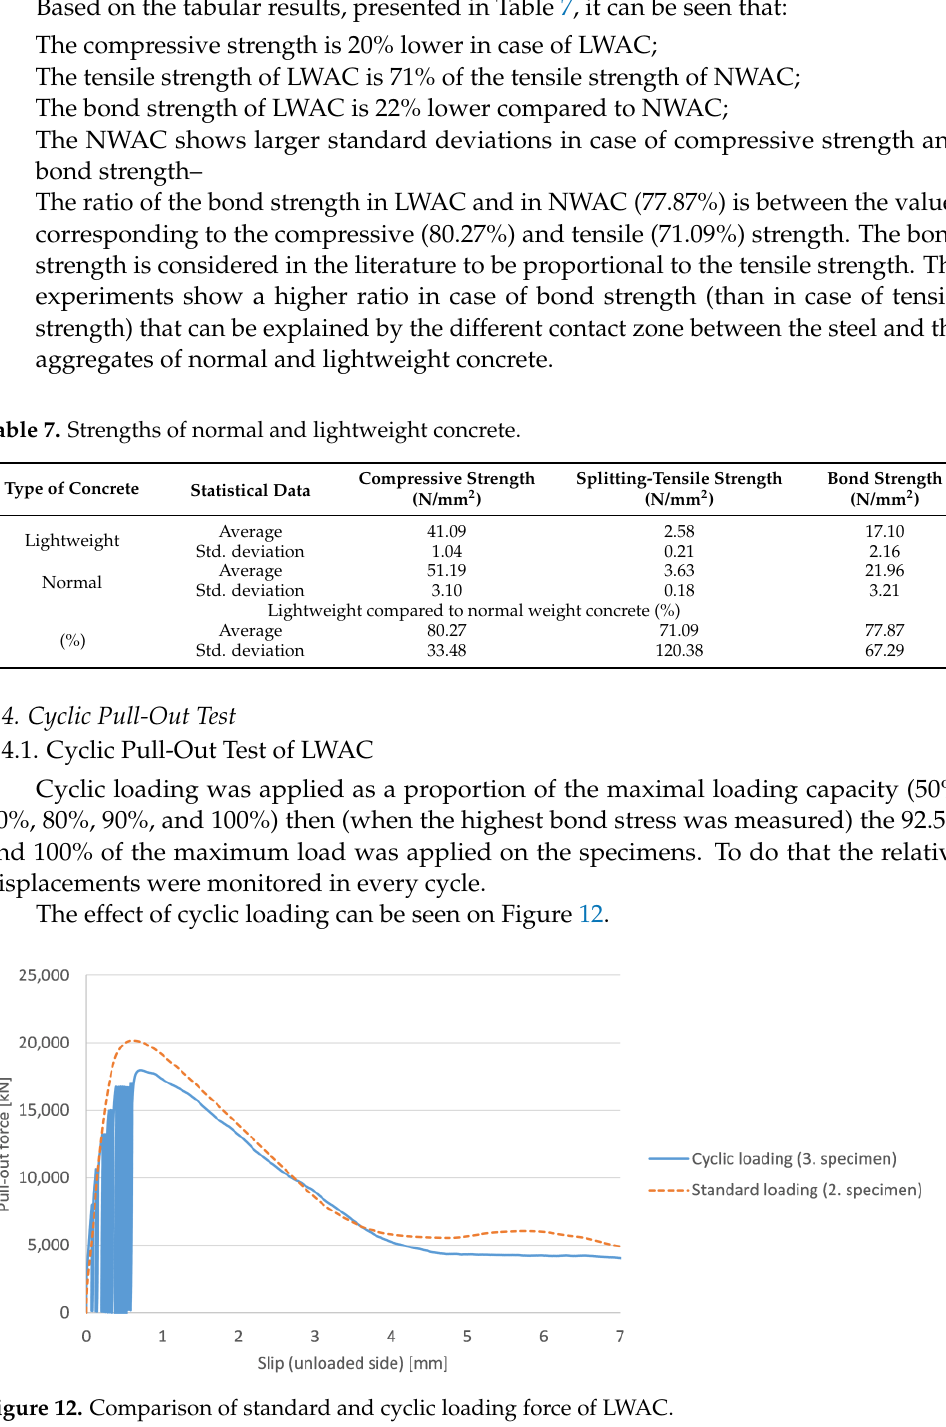
Table 7. Strengths of normal and lightweight concrete.